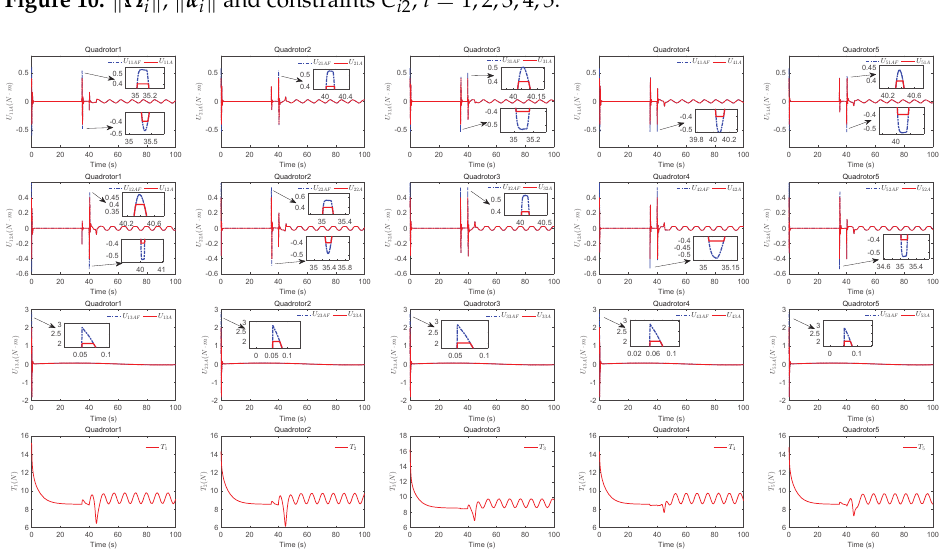
Figure 10. (cid:107) Ω i (cid:107) , (cid:107) α i (cid:107) and constraints C i 2 , i = 1,2,3,4,5.